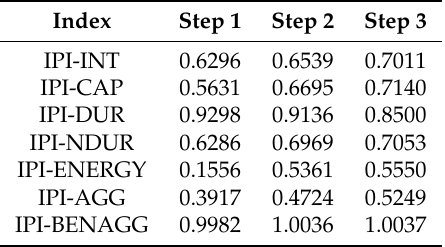
Table 22. Comparison between RMSE ratios with an expanding window from 2008:01 to